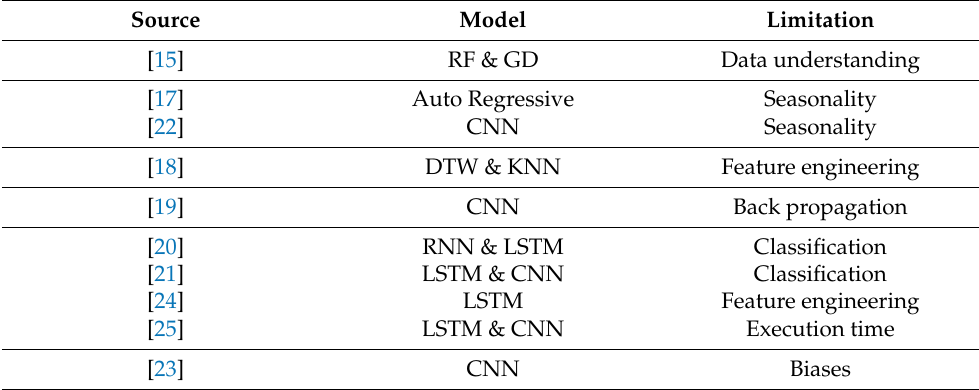
Table 1. Comparative